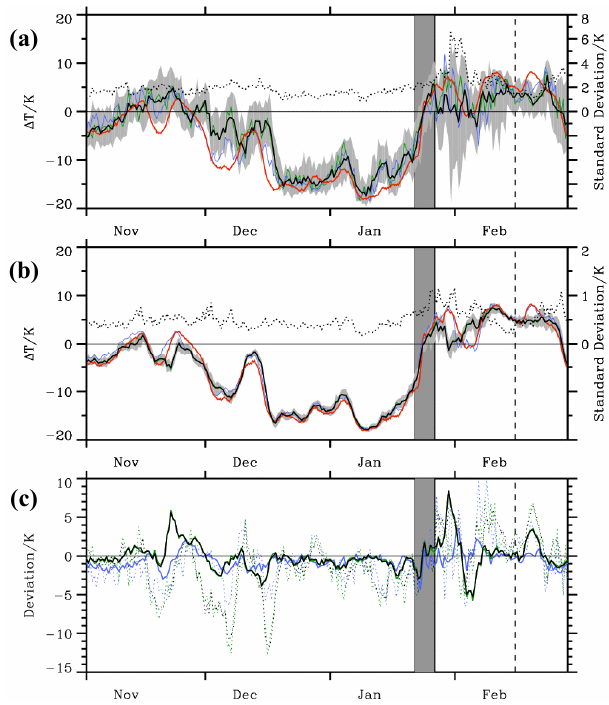
Fig. 14. Time series of 240h (a) and 120h (b) forecasts of the meridional temperature difference 1T 50 at 50hPa for the winter 2009–2010. Results are shown for high-resolution deterministic (blue solid), lower-resolution EPS control forecasts (green solid), and the ensemble mean (black solid). The area between the minima and maxima of 1T 50 from all 50 EPS members are shaded in grey. The dotted lines in the upper panels are the standard deviations of 1T of the ensemble predictions. Also shown is the verifying op- erational analysis (red solid). The meridional temperature gradient 1T 50 is computed from zonally averaged differences between the polar cap (75 to 90 ◦ N) and the mid-latitudes (50 to 65 ◦ N). The bottom panel (c) shows the deviations between the verifying anal- yses and deterministic forecast (blue), the control forecast (green), and the ensemble mean (black), respectively. Solid lines are for the 5-day, dotted lines for the 10-day forecast. The grey shaded column marks the 5 day period after the mean temperature gradient between 85 and 60 ◦ N is positive and the vertical thick solid line marks the central date of the major warming event on 26 January 2010.